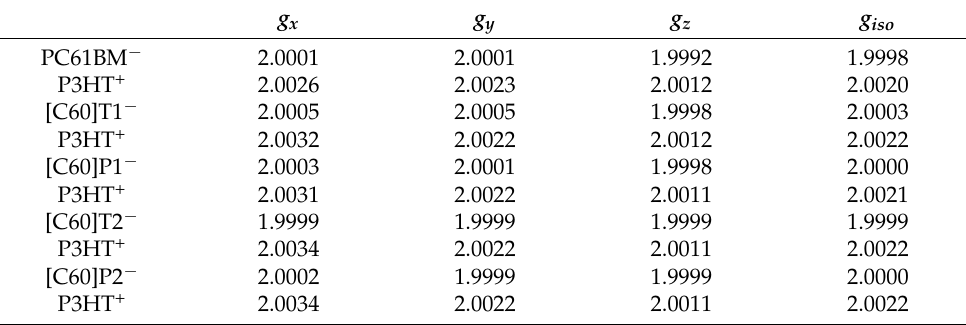
Table 2. g-tensor components obtained for all studied fullerene-derivative–P3HT blends. g x g y g z g